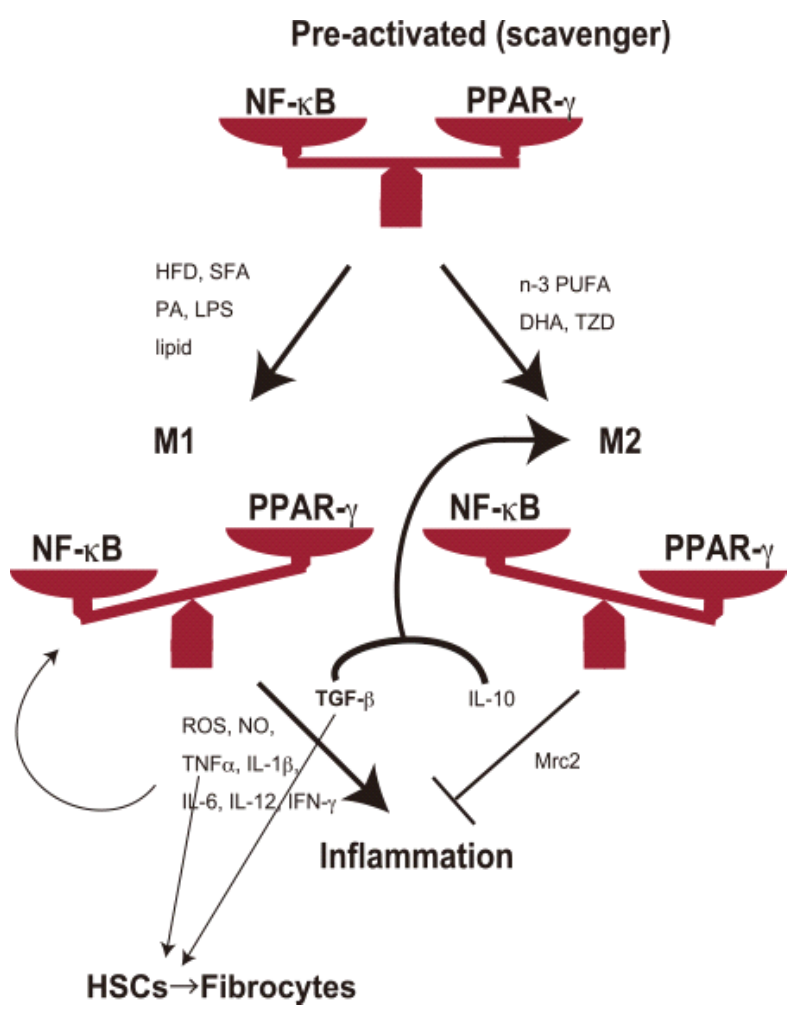
Figure 1. KCs maintain a heterogeneous population of macrophages. KCs act as scavengers (preactivated (unpolarized) phase) for debris from dead cells or damaged cells to maintain normal conditions. Spontaneous KC damage or depletion may lead to the accumulation of damaged cells in the liver, followed by the prevalence of NAFLD. TGF ‐β and IL ‐ 10 may skew KCs to the M2 phenotype. Pro-fibrotic cytokines (TNF ‐α and TGF ‐β ) also promote HSCs to fibrogenesis, followed by cirrhosis. Hepatic stressors include overnutrition (HFD, SFA, lipids) and endotoxins (e.g., LPS). HFD, high-fat diet; SFA, saturated fatty acid; PA, palmitic acid; LPS, lipopolysaccharide; PUFA, polyunsaturated fatty acid; DHA, docosahexaenoic acid; TZD, thiazolidinedione.